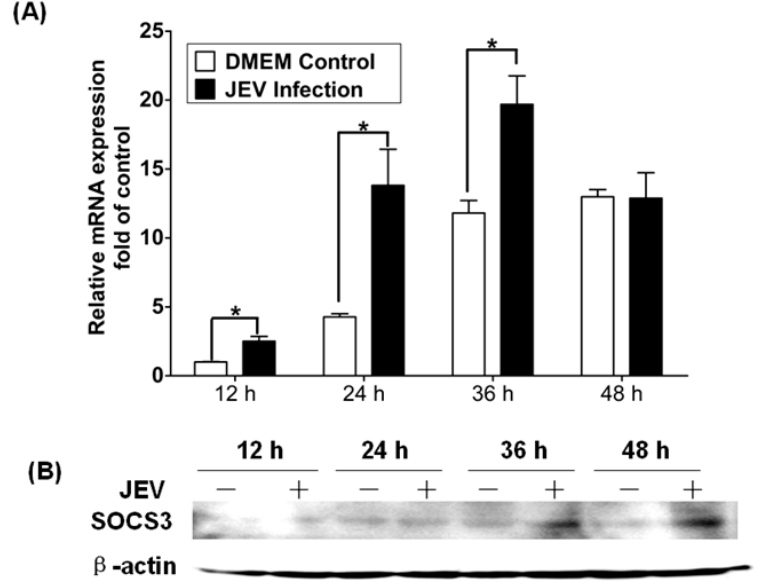
Figure 4. Change of SOCS3 expression in mouse brain infected with JEV. Mice brains were subcutaneously injected with JEV (SX09S01) using a viral titer of 1.58 × 10 5 tissue culture infective dose (TCID) 50 , and samples were collected at different time points post-infection. ( A ) Quantitative RT-PCR was performed with RNA extracted from mock-infected or wild-type JEV-infected mice brains 12 h, 24 h, 36 h and 48 h p.i. The results were expressed as the fold change in relative mRNA expression over the control. ( B ) Expression of SOCS3 protein in mock-infected or wild-type JEV-infected mice brains was analyzed by Western blotting. Data are expressed as the mean ± SD from four independent experiments, and significance was evaluated by GraphPad Prism 5 software. Differences were assessed by using unpaired Student’s t -tests. * p <